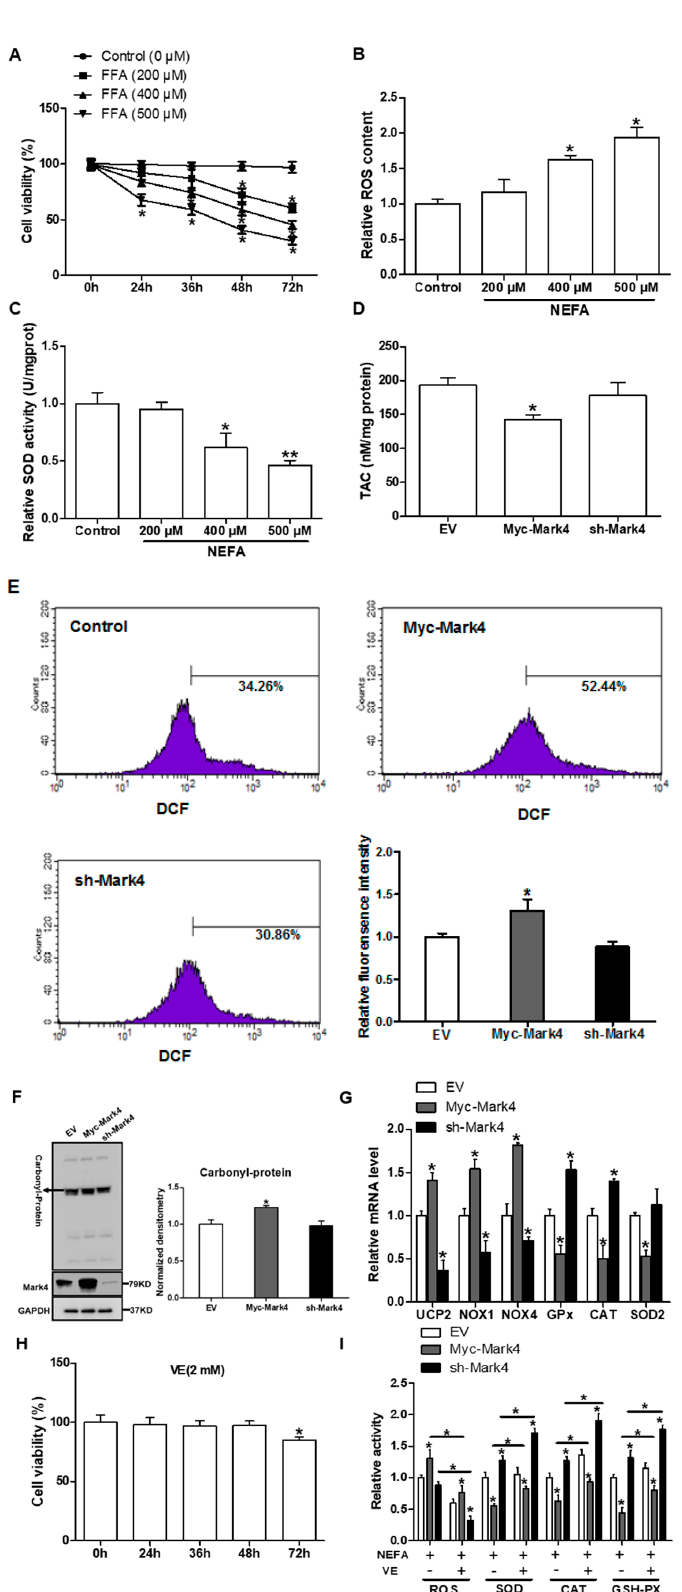
Figure 1. MARK4 promotes oxidative stress in pig primary trophoblast cells. ( A ) Primary cytotroph- oblasts isolated from pig placentas were cultured and incubated for 0, 24, 36, 48, and 72 h in the presence of 200, 400, or 500 µ M NEFA. Cell viability was detected by CKK-8 ( n = 3). ( B , C ) The